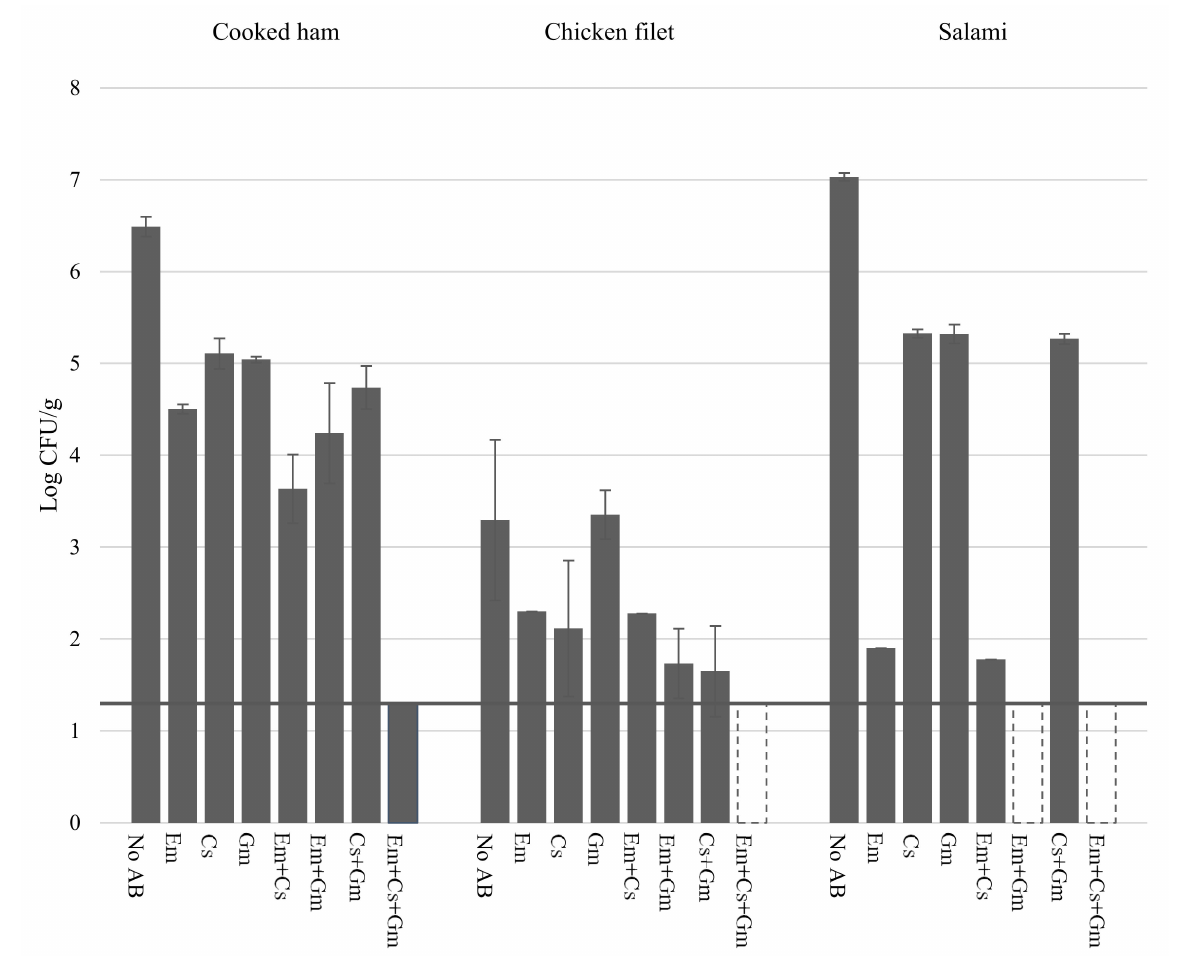
Figure 4. Anaerobic plate counts of background bacteria from cooked ham, chicken filet, and salami on RCM agar, and RCM agar with different combinations of the antibiotics Em (3 µ g/mL), Cs (100 µ g/mL) and Gm (15 µ g/mL). Horizontal line indicates lower detection limit. Bars in dashed lines indicate complete absence of colonies. Error bars represent standard deviation of three independent samples from the same food packaging